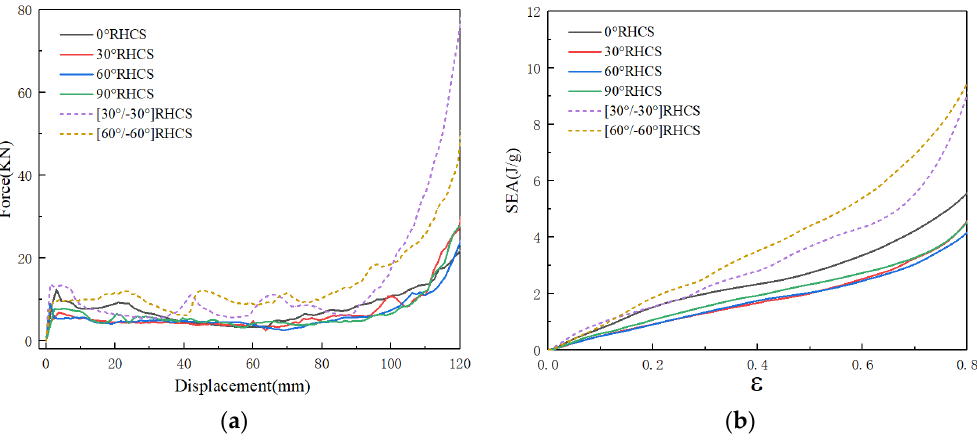
Figure 15. ( a ) The force–displacement curves of RHCSs and ( b ) the SEA curves of RHCSs when V = 10 m/s.